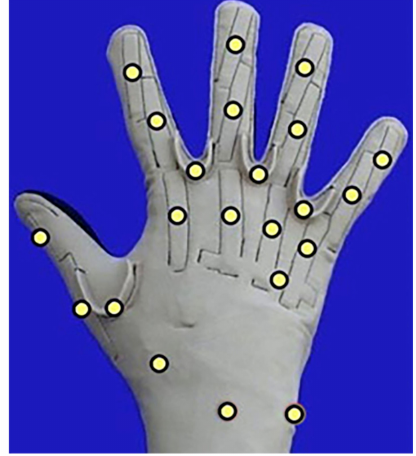
Figure 4. Strain gauge placement of the CyberGlove